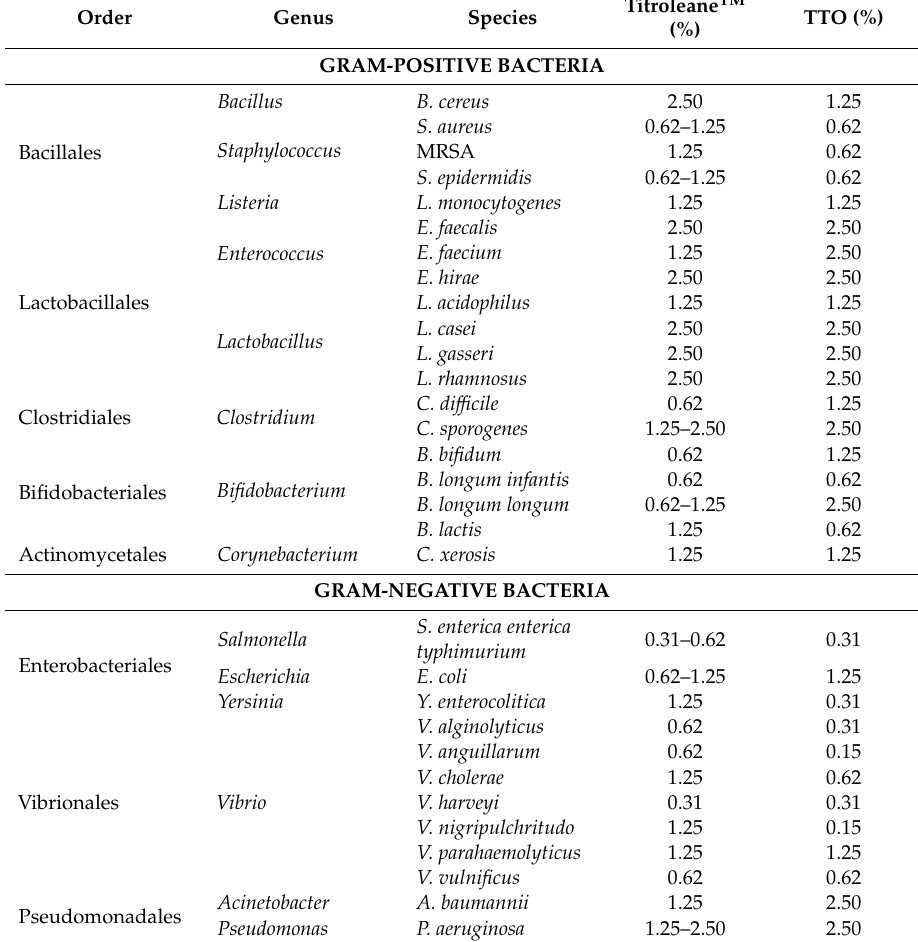
Table 5. Comparison of the minimal inhibitory concentrations (MICs) of Titroleane ™ and Tea Tree oil (TTO). They were prepared and tested the same